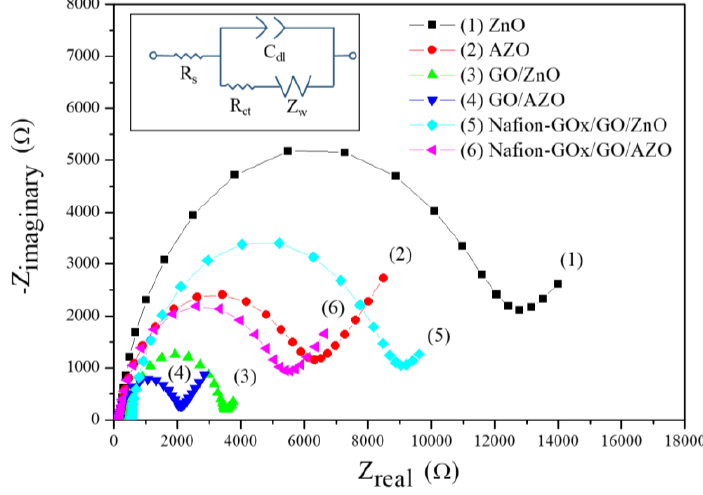
Figure 9. Nyquist plots of different membranes obtained by fitting of EIS. Table 2. Charge transfer resistances obtained by the fitting of EIS. PBS: phosphate-buffered saline.